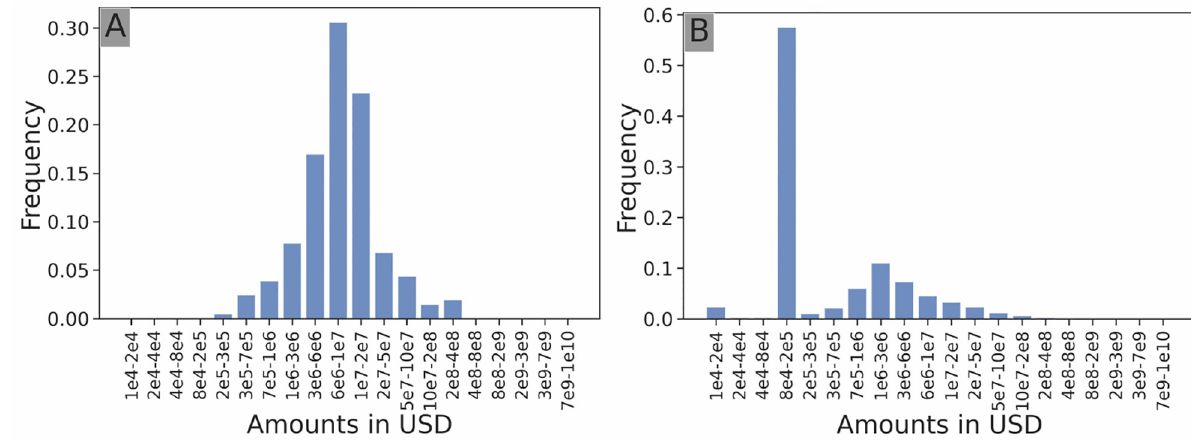
Fig 6. Amount investment distribution. Amount investment distribution of Softbank Capital ( A ) and Y Combinator ( B ). In line with Fig 5, we see that Softbank Capital invests relatively high amounts (peak frequency of investment between 6 million USD and 10 million USD) whereas Y Combinator invests smaller amounts in a very systematic manner (peak frequency of investment between 80 000 USD and 200 000 USD). This is in line with the accelerator model where accelerators invest a set amount in all ventures they decide to support. Furthermore, Y Combinator has also developed funds such as Y Combinator Continuity dedicated to investing in its alumni companies after their initial investment. This can be seen in the small bump in the funding amount distribution between 700 000 USD and 10 million USD.